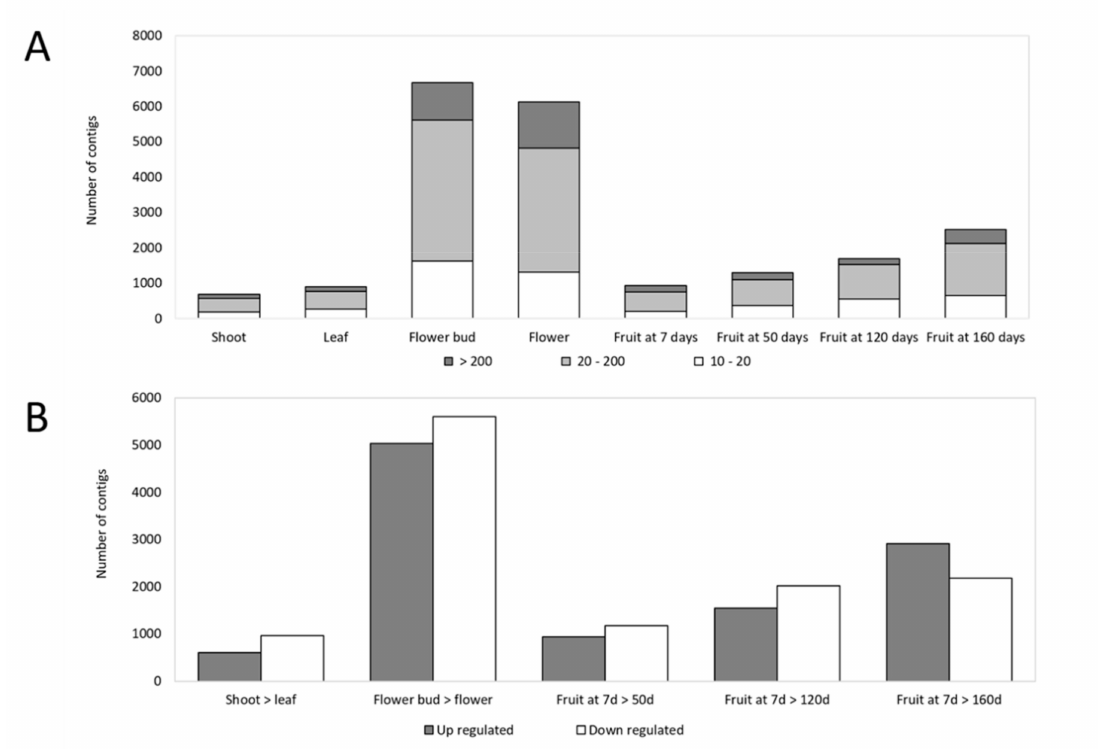
Figure 5. ( A ) Number of expressed contigs by plant tissue (above). Contig expression is shown in white color (10–20), grey (20–200) and dark grey (>200). ( B ) Number of expressed contigs by tissue comparison (below). Up-regulated (grey color) and down-regulated (white color)